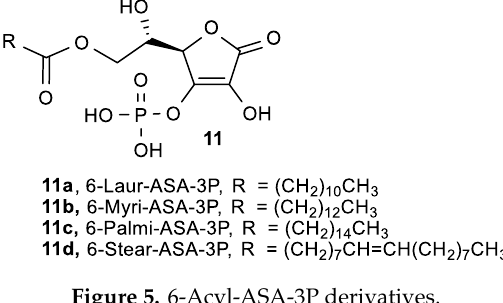
Figure 5. 6-Acyl-ASA-3P derivatives. Table 2. The radical scavenging activity and cytotoxicity of 6- O -acyl- l -ascorbic acid-3- O -phosphates on 95-D cells.